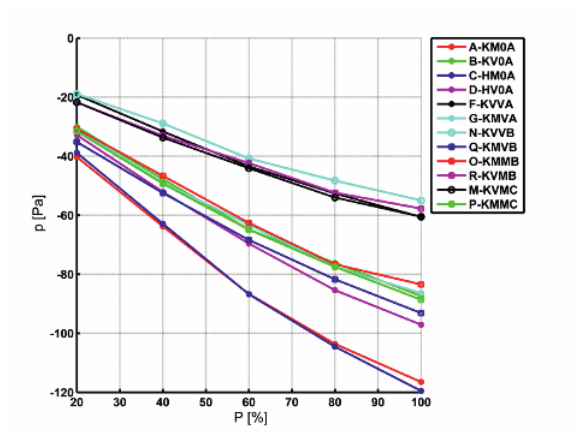
Fig. 6. Pressure variation for each configuration and di ff erent fans performance P.